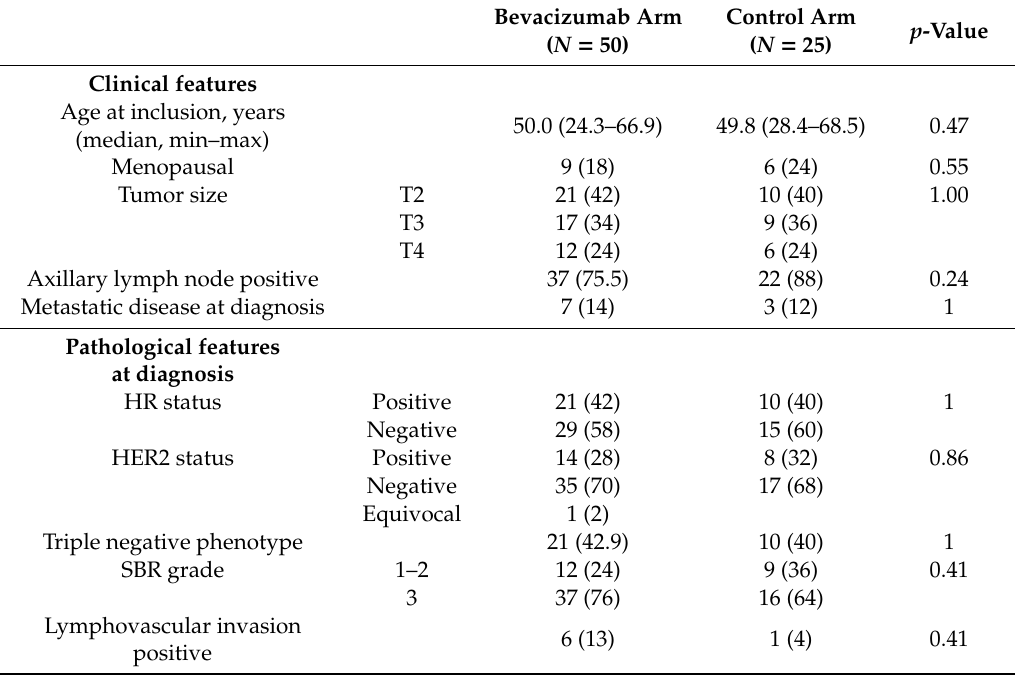
Table 1. Clinical and pathological features at inclusion. When required, results are notified as N (% of cases with data